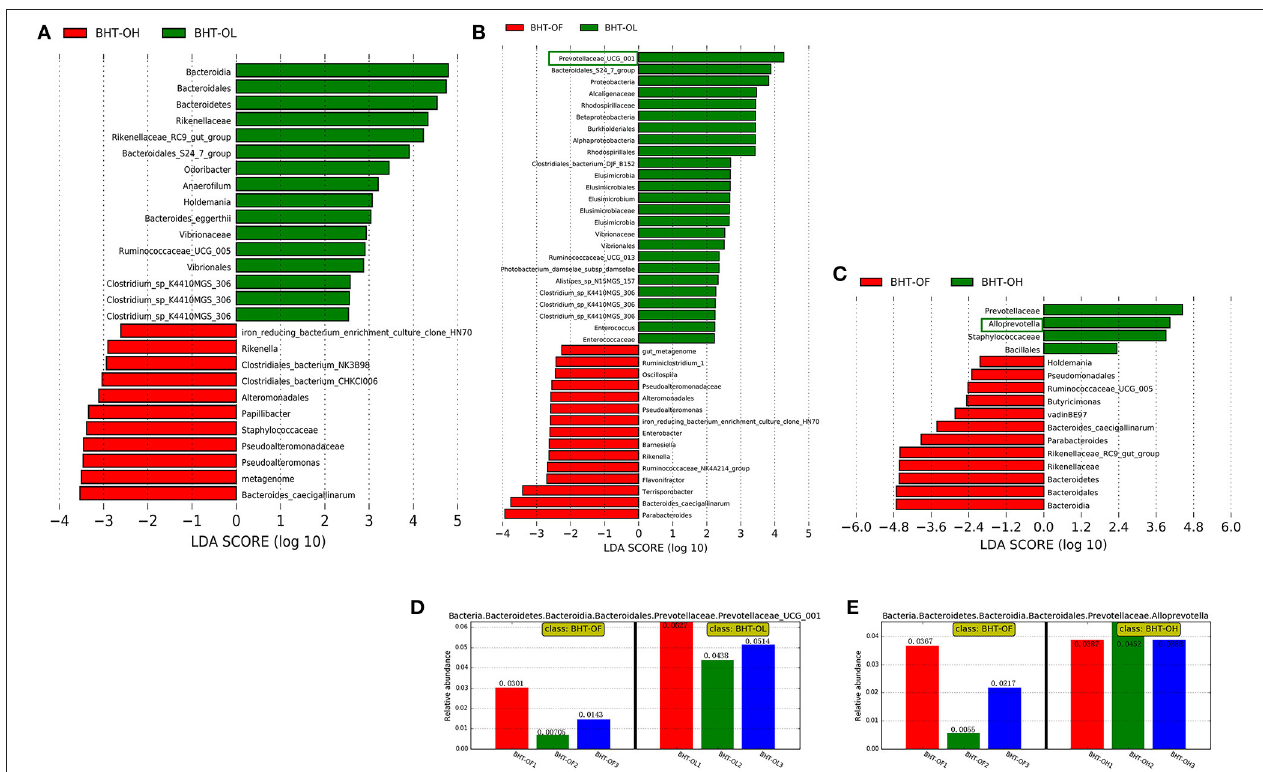
FIGURE 4 | Linear discriminant analysis (LDA) among the groups of Bian hens–20 weeks (BHT) and abundance histograms of the dominant bacteria. (A) BHT-OL vs. BHT-OH. (B) BHT-OL vs. BHT-OF. (C) BHT-OF vs. BHT-OH. A value of LDA > 2 represents that the difference in the relative abundances of certain microbes was significant between groups. (D) The abundance histogram of dominant fiber-degrading genus Prevotellaceae_UCG-001 (green frame, Figure 2B ) in the OL group compared to the OF group. (E) The Abundance histogram of dominant fiber-degrading genus Alloprevotella (green frame, Figure 2C ) in the OH group compared to the OF group. OL, OptiCell (OC)-low; OH, OC-high; OF,